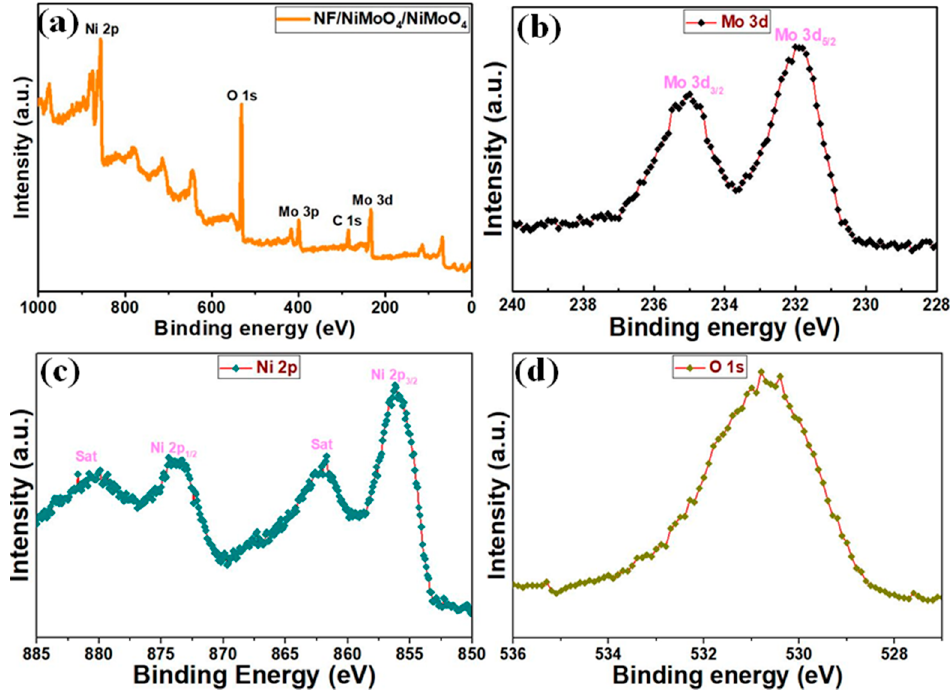
Figure 4. XPS survey spectrum ( a ), Mo 3d ( b ), Ni 2p ( c ) and O 1s ( d ) of the NF/NiMoO 4 /NiMoO 4 composite material.